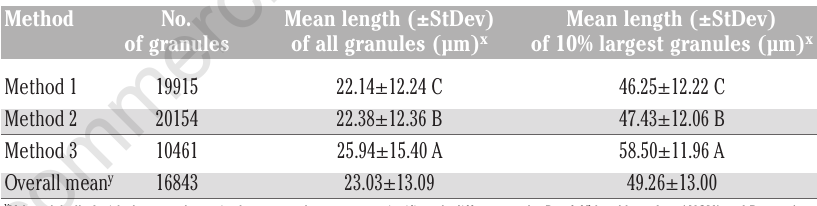
Table 1. ANOVA analysis and sampling method comparison for the determination of starch granule size.